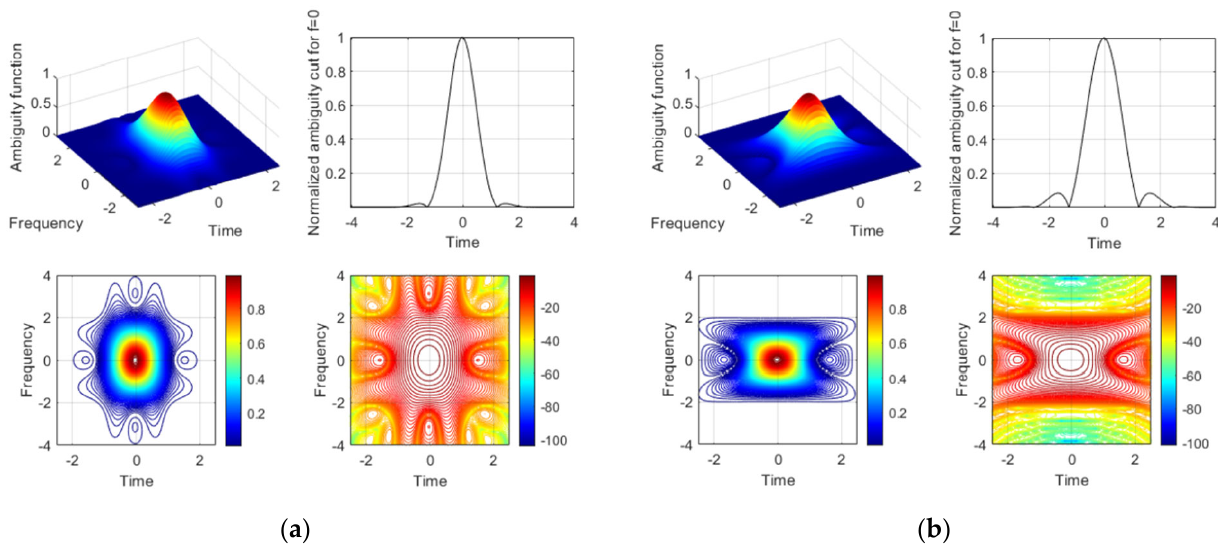
Figure 8. Ambiguity function comparison of the Hermite ( a ) and PHYDYAS ( b ) prototype filters.